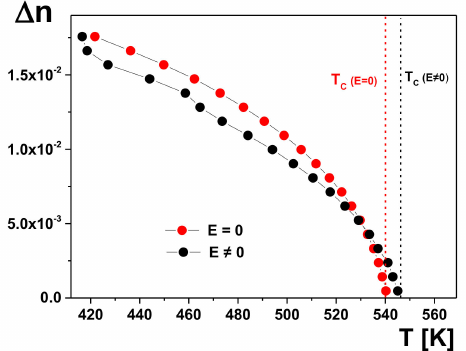
Figure 6. The influence of electric field on birefringence of PZT single crystal subjected to the field having the strength of 7 kV / cm. Calculations of ∆ n were carried out for a single-domain region measuring 25 µ m × 30 µ